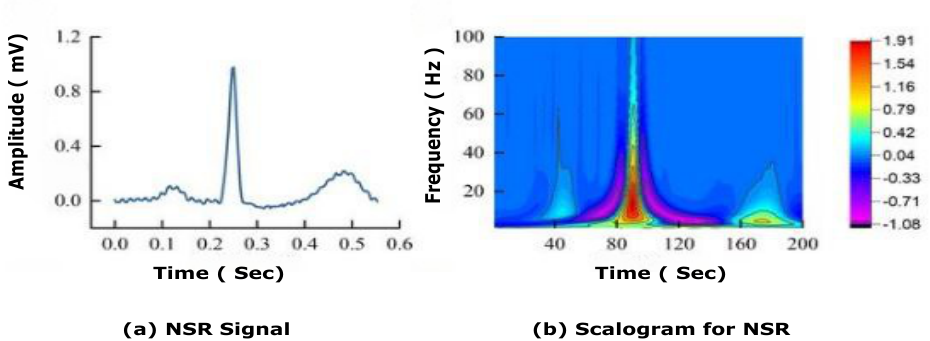
Figure 3. Conversion of normal sinus rhythm (NSR) signal into scalogram image. Sub-figures ( a , b ) represents NSR signals and CWT scalogram for